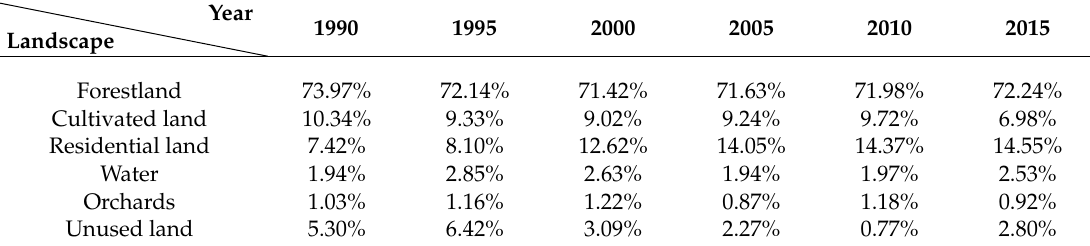
Table 16. Percent of landscape (PLAND) for various types of landscape.